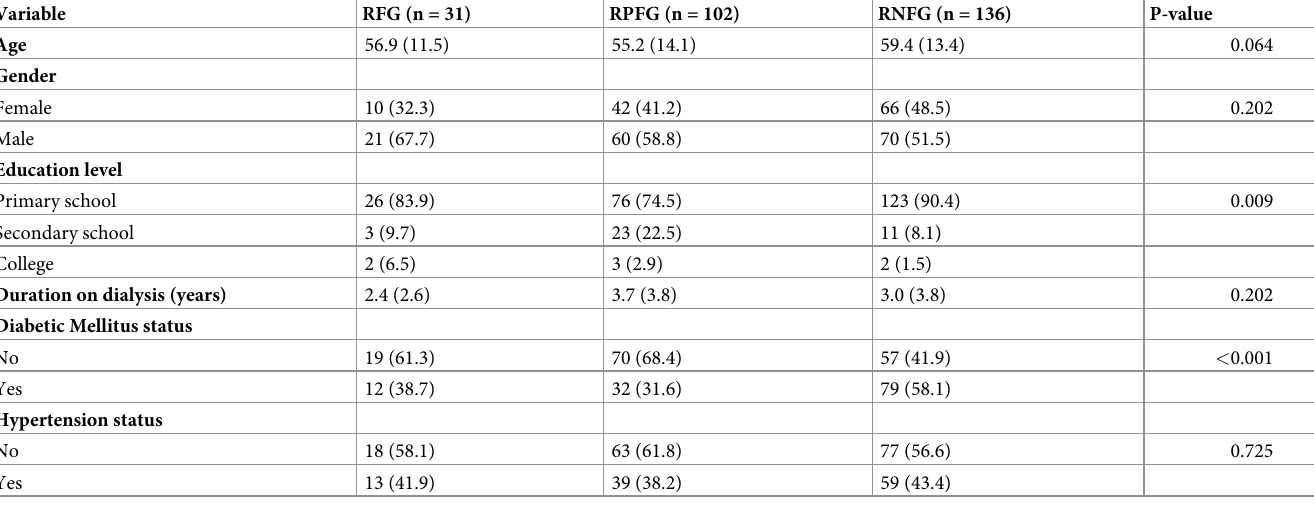
Table 1. Baseline demographic and biomedical characteristics of hemodialysis patients by Ramadan fasting group.